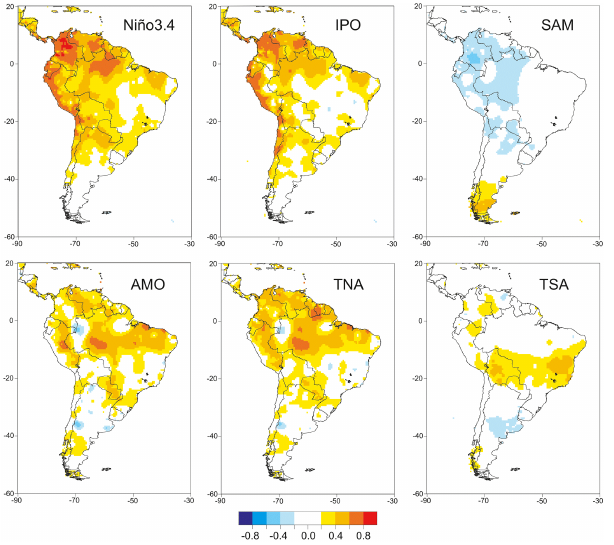
Figure 3. Annual mean temperature regressed upon Niño3.4, IPO (Interdecadal Pacific Oscillation), SAM (Southern Annular Mode), AMO (Atlantic Multidecadal Oscillation), TNA (tropical North At- lantic SST), and TSA (tropical South Atlantic SST). High positive values of the regression coefficient indicate that positive (negative) temperature anomalies occur during the positive (negative) phase of the mode in question. High negative values indicate that the pos- itive (negative) phase of a mode leads to a decrease (increase) in temperature at the grid cell. Gridded temperature fields are from the University of Delaware